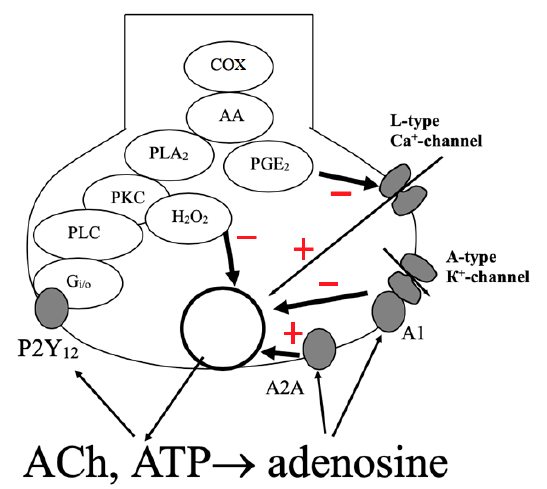
Figure 1. Schematic diagram of presynaptic regulation by ATP of neuromuscular transmission in frog phasic muscles. The synaptic vesicle filled with ACh and ATP releases its content by exocytosis into the synaptic cleft. ATP and its metabolite, adenosine, are both involved in separate negative feedback mechanisms: ATP via P2Y 12 receptors and adenosine via adenosine A 1 and A 2A receptors.